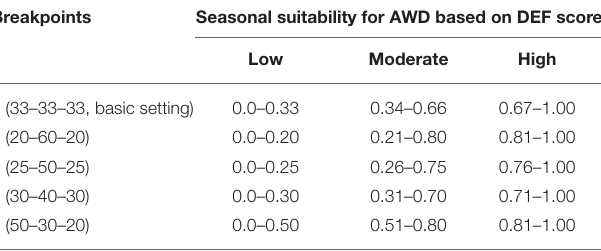
TABLE 4 | Breakpoints for the DEF score index as used in the sensitivity analysis on low, moderate, and high suitability for AWD. Breakpoints Seasonal suitability for AWD based on DEF score Low Moderate